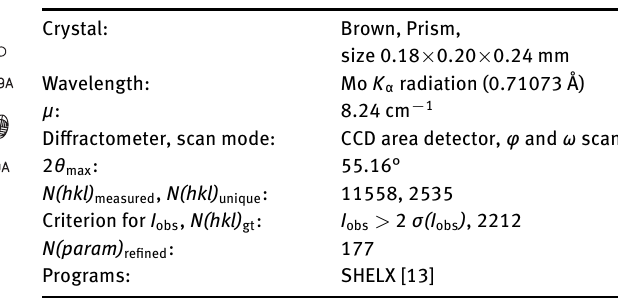
Table 2: Fractional atomic coordinates and isotropic or equivalent isotropic displacement parameters (Å 2